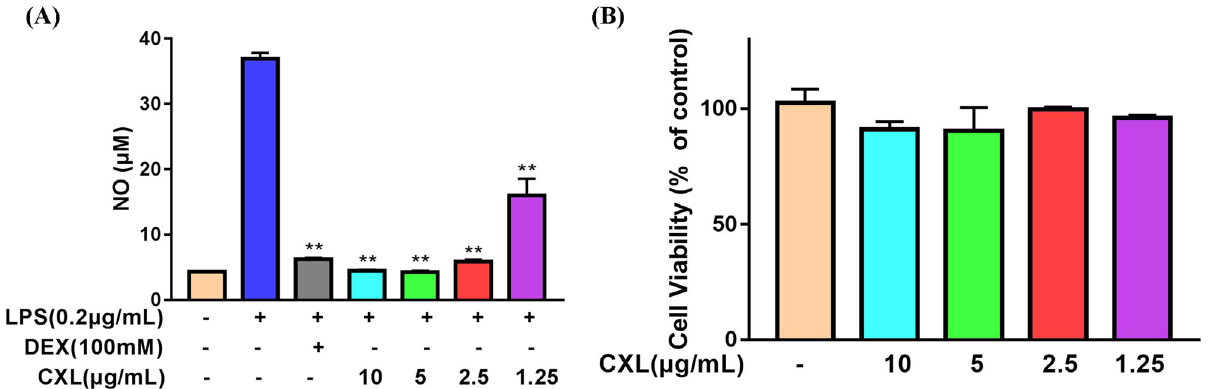
Figure 7. Effect of Chuan Xinlian extract on RAW264.7. ( A ) Cell viability was detected using the CellTiter- Lumi™ Plus assay; and ( B ) NO production was assessed by the Griess reaction (compared with LPS group, * p < 0.05, ** p < 0.01, n =